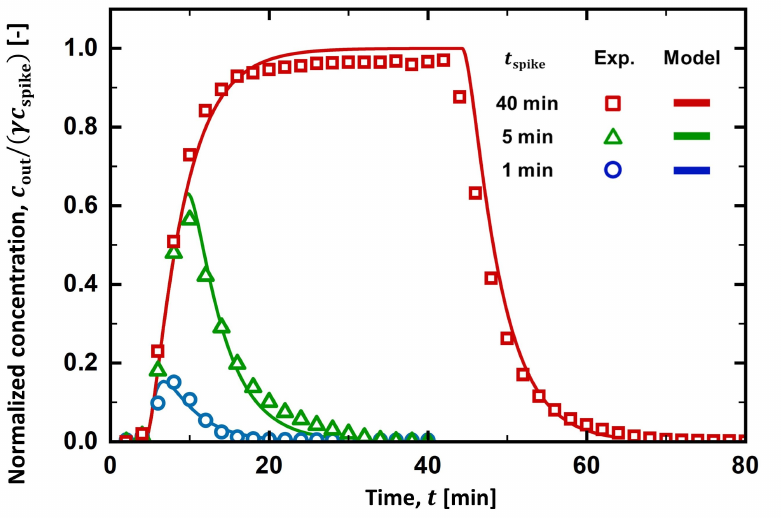
Figure 5. Effect of spiking duration on the RTD curves when the feed flow rate is 0.41